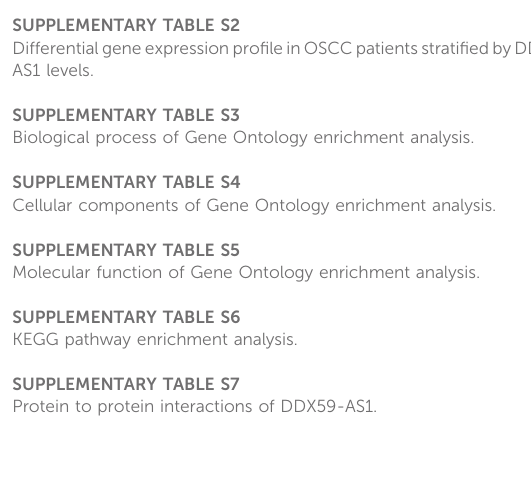
SUPPLEMENTARY FIGURE S1 Disease-Speci fi c Survival for subgroup analyses. (A) T stage; (B) N stage; (C) M stage; (D) Clinical stage; (E) Primary therapy outcome; (F) Gender; (G) Race; (H) Age; (I) Histologic grade; (J) Smoker; (K) Alcohol; (L) Perineural invasion; (M) Lymph vascular invasion; (N) TP53 status; (O) PIK3CA status. SUPPLEMENTARY FIGURE S2 Construction of protein-protein interaction network of DDX59-AS1 and its co-expressed genes. SUPPLEMENTARY FIGURE S3 Immune In fi ltration Analysis of Oral Squamous Cell Carcinoma Dataset TCGA-OSCC (CIBERSORT). (A) Histogram display of immune in fi ltration results of 22 types of immune cells in the TCGA-OSCC dataset; (B) Group comparison chart of immune in fi ltration results of TCGA-OSCC dataset; (C) Heat map display of the correlation analysis results of 22 immune cells; (D) Lollipop chart display of the correlation analysis results between the target gene DDX59-AS1 and the in fi ltration abundance of 22 types of immune cells. SUPPLEMENTARY FIGURE S4 Correlation analysis of target gene DDX59-AS1 and immune cell in fi ltrationabundance. (A) TargetgeneDDX59-AS1andimmunecells (A) B cells memory; (B) Dendritic cells resting; (C) Eosinophils; (D) Mast cells activated; (E) Mast cells resting; (F) NK cells resting; (G) Results of correlationanalysisbetweenTcellsCD8; (H) Tcellsfollicularhelper,and (I) T cells regulatory (Tregs) in fi ltration abundance. SUPPLEMENTARY FIGURE S5 Immune score (estimate) of OSCC dataset TCGA. (A) StromalScore; (B) ImmuneScore; (C) ESTIMATEScore. SUPPLEMENTARY TABLE S1 Disease-Speci fi c survival prognostic performance of DDX59-AS1 on clinical outcomes in OSCC patient subgroups by Cox regression analysis.